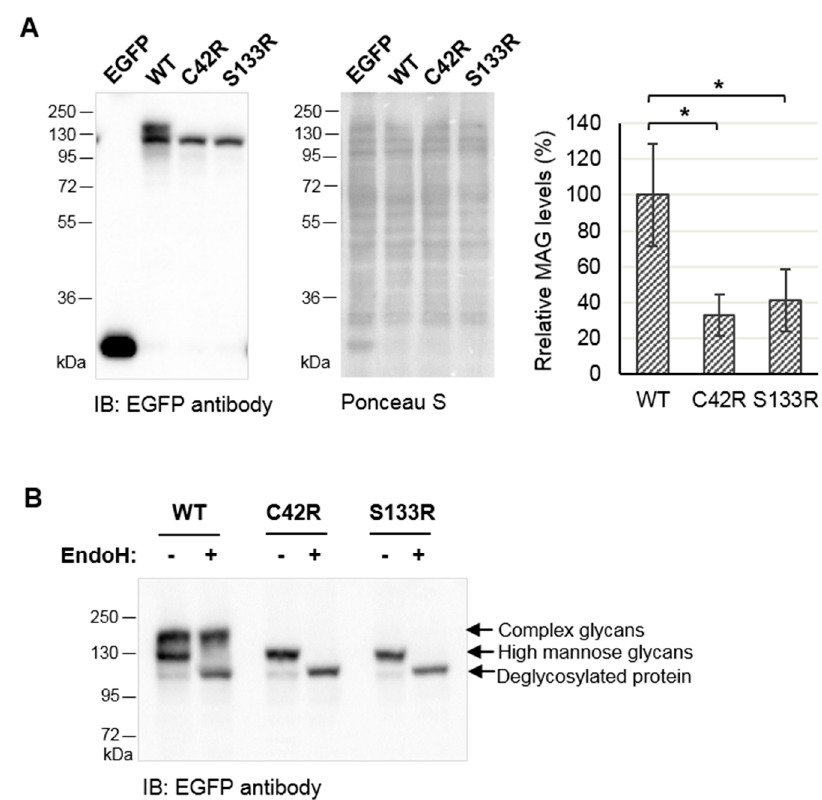
Figure 2. The MAG-C42R variant results in reduced protein expression and impairs glycosylation. ( A ) Analysis of protein expression of EGFP-tagged MAG clones in HEK293T cells by immunoblotting with anti-EGFP antibody. Ponceau S staining was used as the loading control. Quantification data (graph) are presented as the mean ± SD of three independent experiments; * p < 0.05, compared with MAG-WT (one-way ANOVA / Tukey). ( B ) Cell lysates were incubated with EndoH, which cleaves high mannose N-linked glycans but not complex N-linked glycans, and subjected to immunoblotting with anti-EGFP antibody. The original blot is presented in Figure S1.